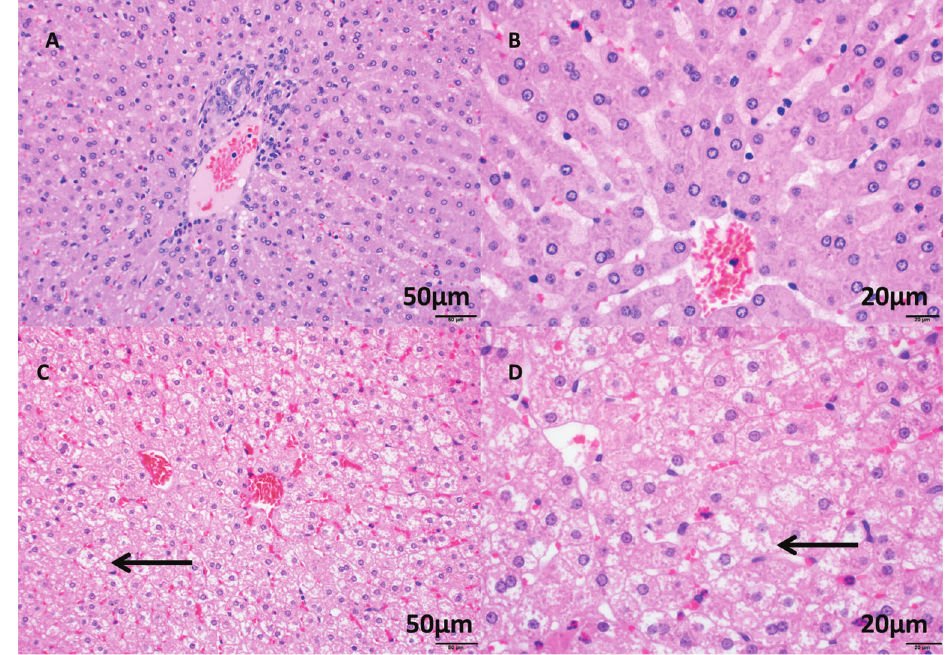
Figure 5. HE staining of liver tissue. The normal hepatocytes are well arranged with centered nuclei, sharp nuclear membrane and red- stained cytoplasm ( A , B ). After the ischemic/reperfusion injury, the hepatocytes are swollen and the hepatic cords are disorganized (arrow in C ). The cytoplasm is lightly stained with vacuoles (arrow in D ).